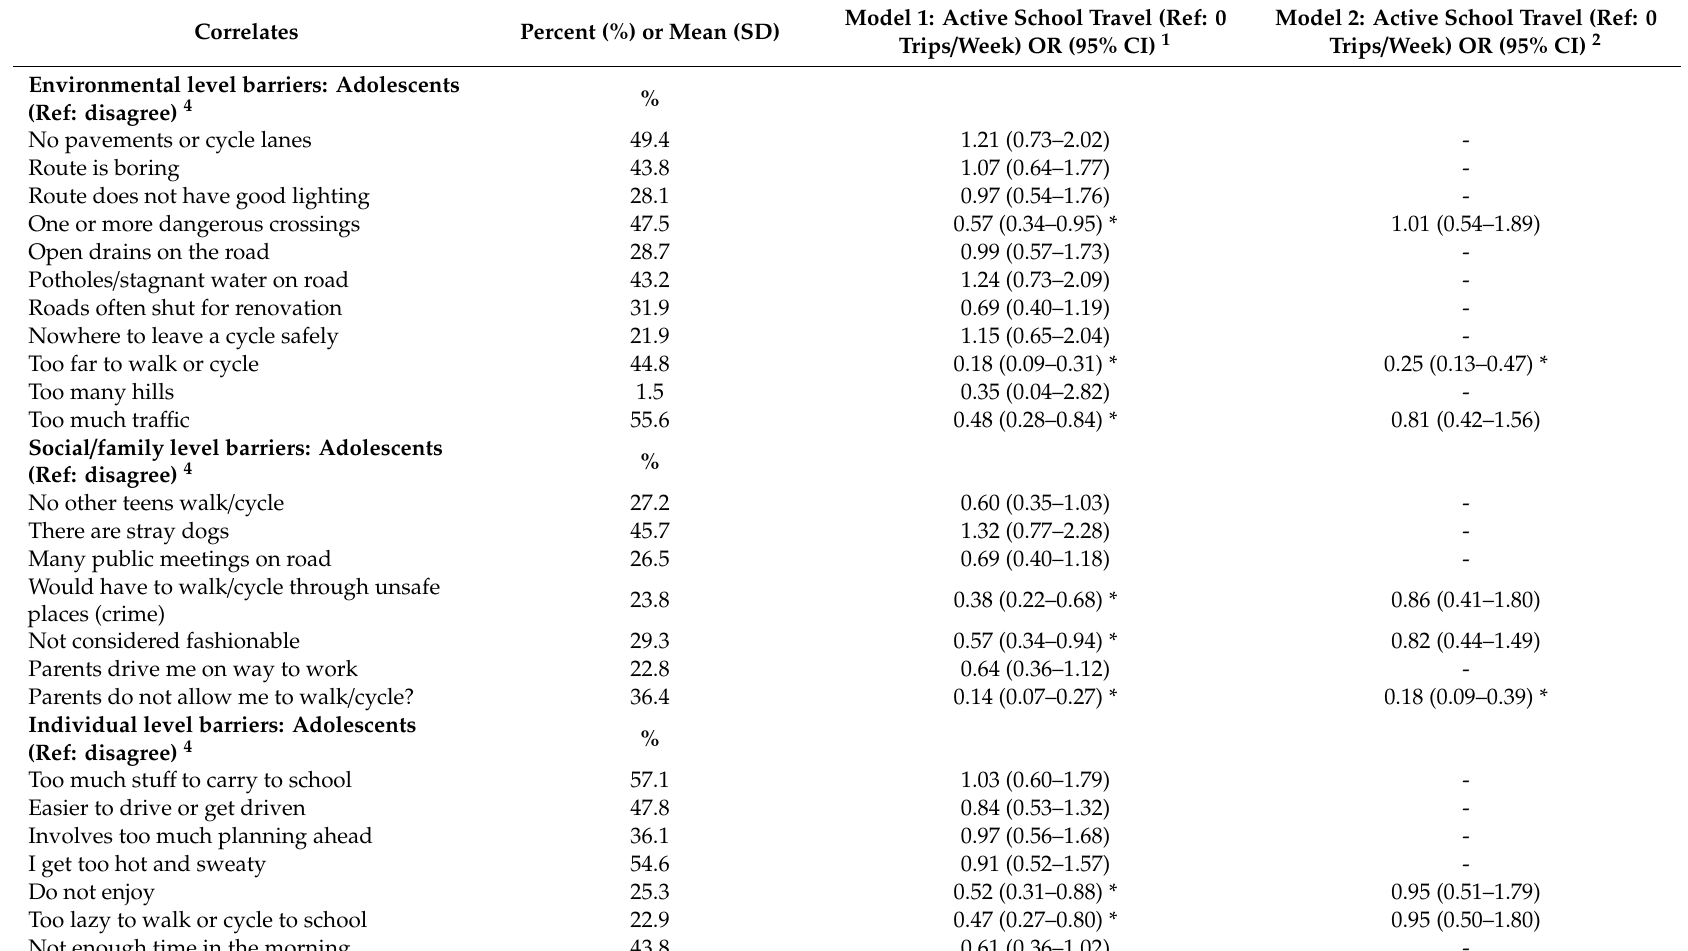
Table 2. Reported barriers (%), perceived neighbourhood environment (mean, sd) and odds of reporting active travel to school ( ≥ 1 trip /